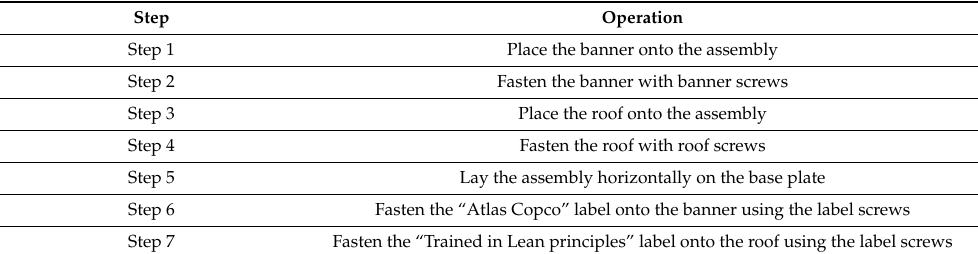
Table 1. Steps of the assembly